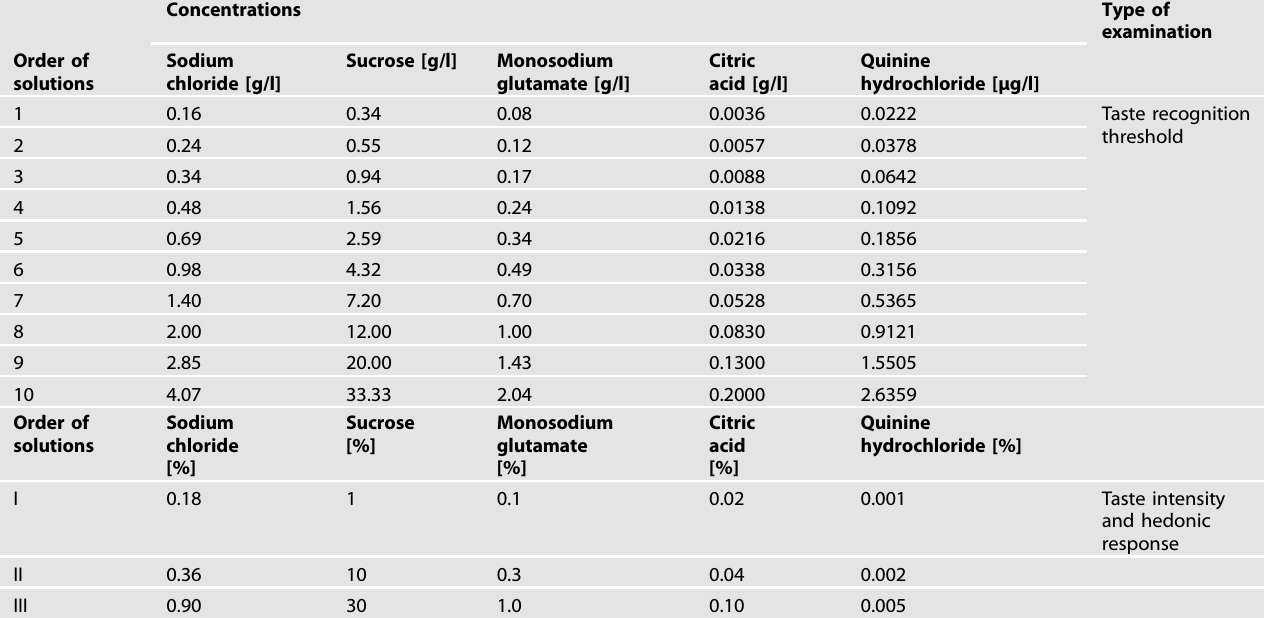
the intensity, hedonic perception and food preferences in diabetic patients (Group Db vs Group Da) were assessed using the Wilcoxon signed-rank test. The statistically signi fi cant difference was set at p < 0.05.